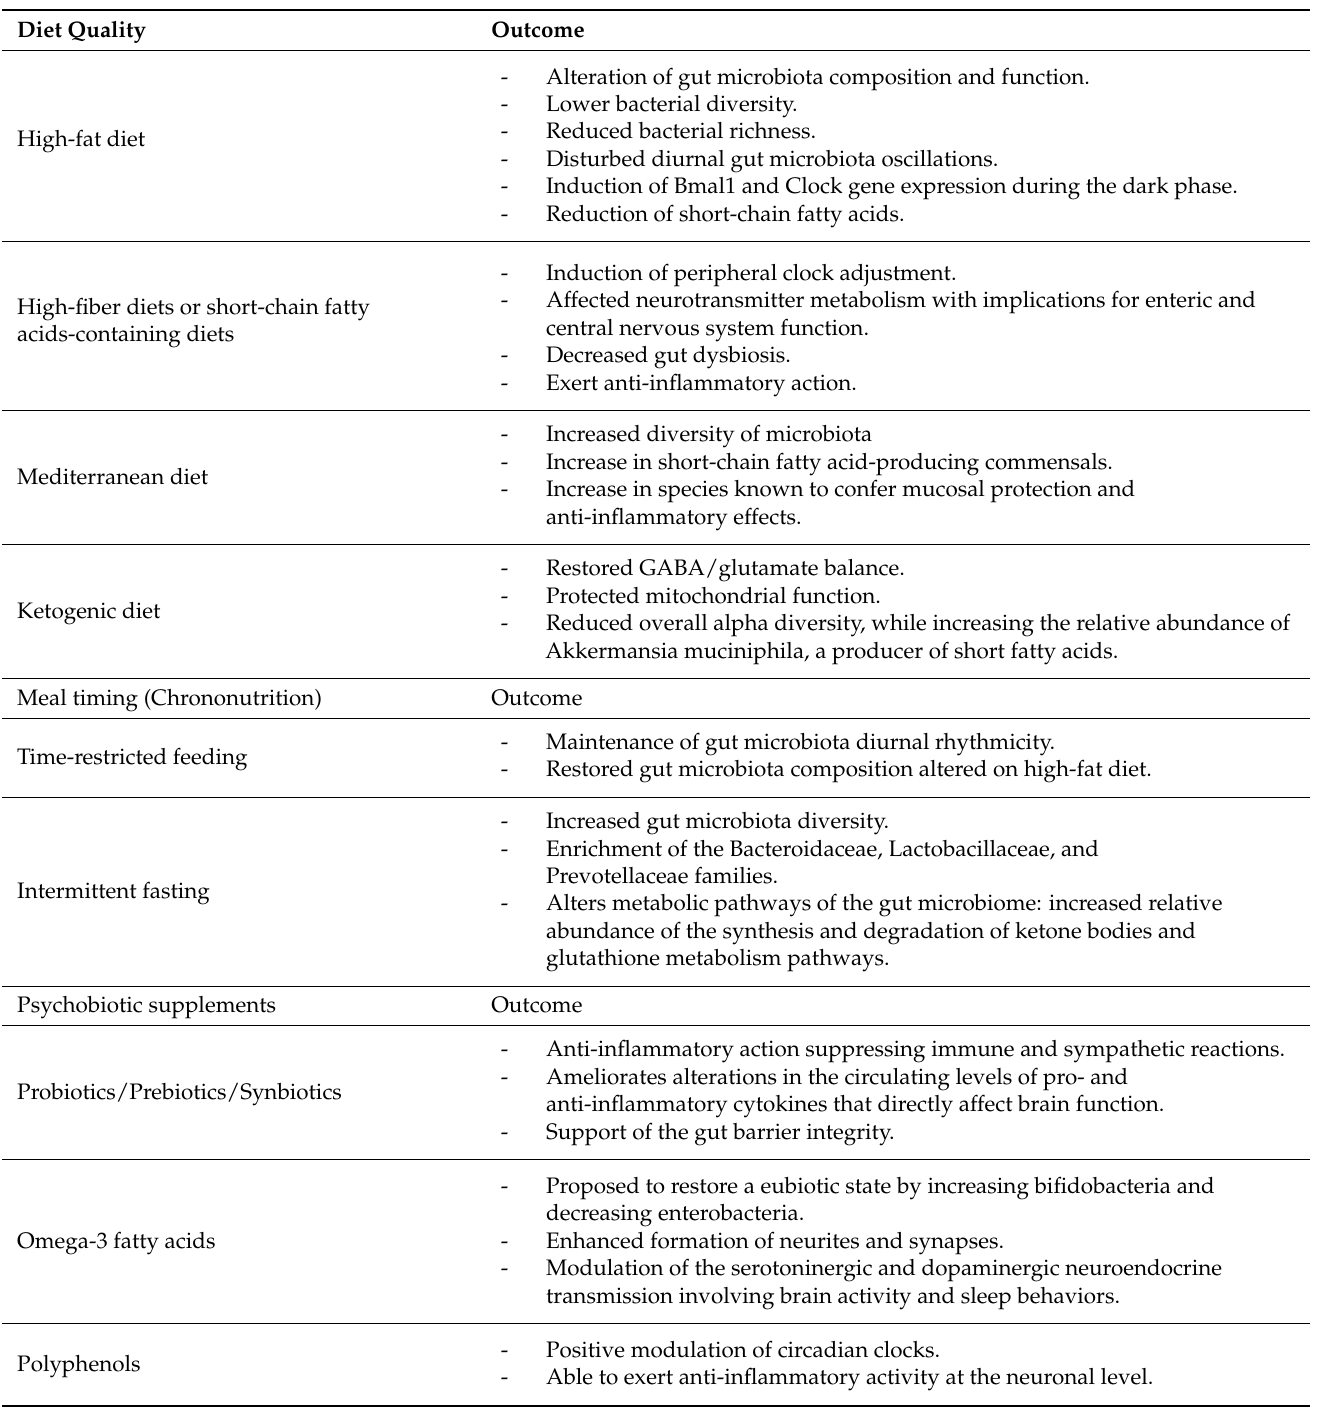
Table 1. Summary of dietary modifications of gut microbiota potentially affecting mental